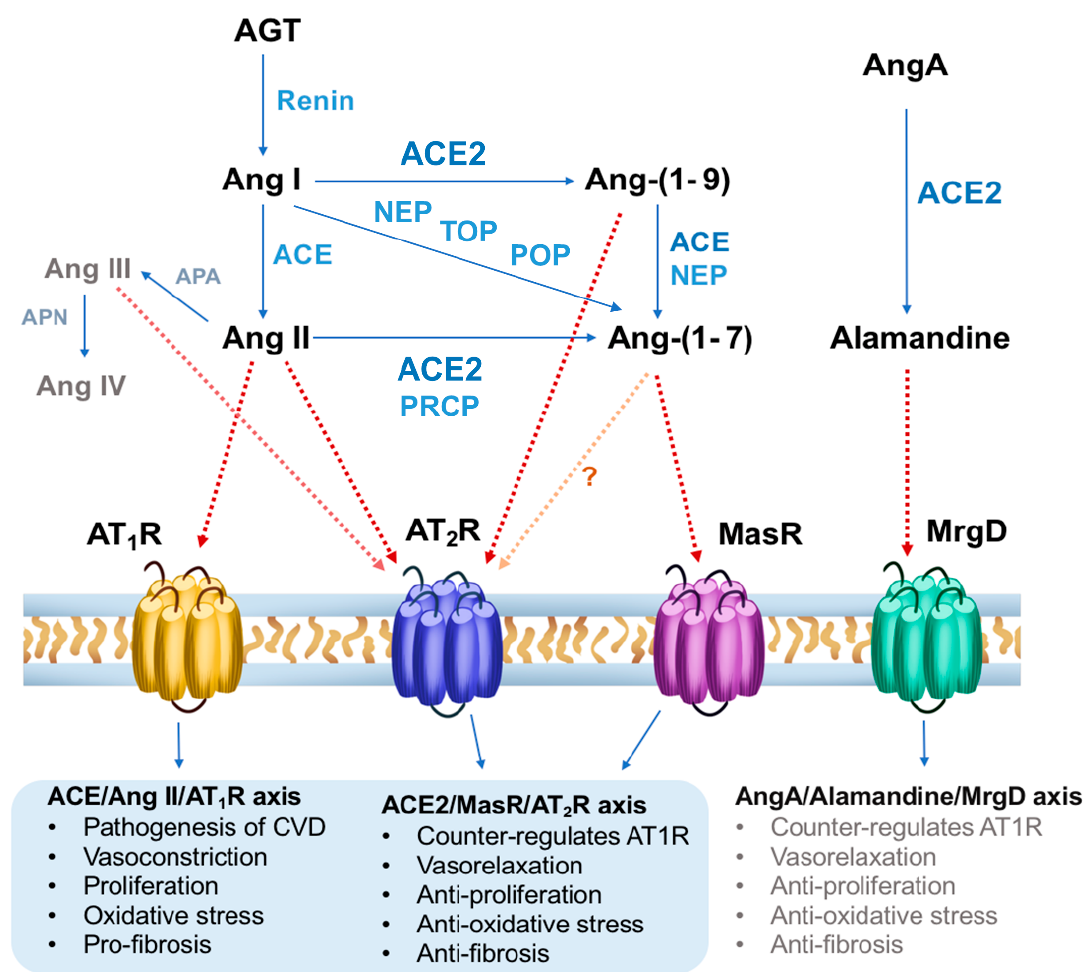
Figure 1. Schematic overview of the renin / ACE / Ang-II / AT 1 R axis, ACE2 / MasR / AT 2 R axis and AngA / Alamandine-MrgD axis, modified from [22]. ACE, Angiotensin converting enzyme; AGT, angiotensinogen; Ang, angiotensin; APA, aminopeptidase A; APN, aminopeptidase N; AT 1 R, angiotensin II type 1 receptor; AT 2 R, angiotensin II type 2 receptor; MasR, Mas receptor; MrgD, Mas-related G-protein coupled receptor type D; NEP, neutral endopeptidase, POP, prolyloligopeptidase; PRCP, prolylcarboxypeptidase; TOP, thimet oligopeptidase. Ang-(1-9) is another interesting metabolite due to its anti-hypertensive actions. It is generated from Ang I and induces AT 2 R-mediated vasodilation, natriuresis, decreased CV remodeling and anti-proliferation [23]. In hypertensive models, Ang-(1-9) has been shown to ameliorate CV